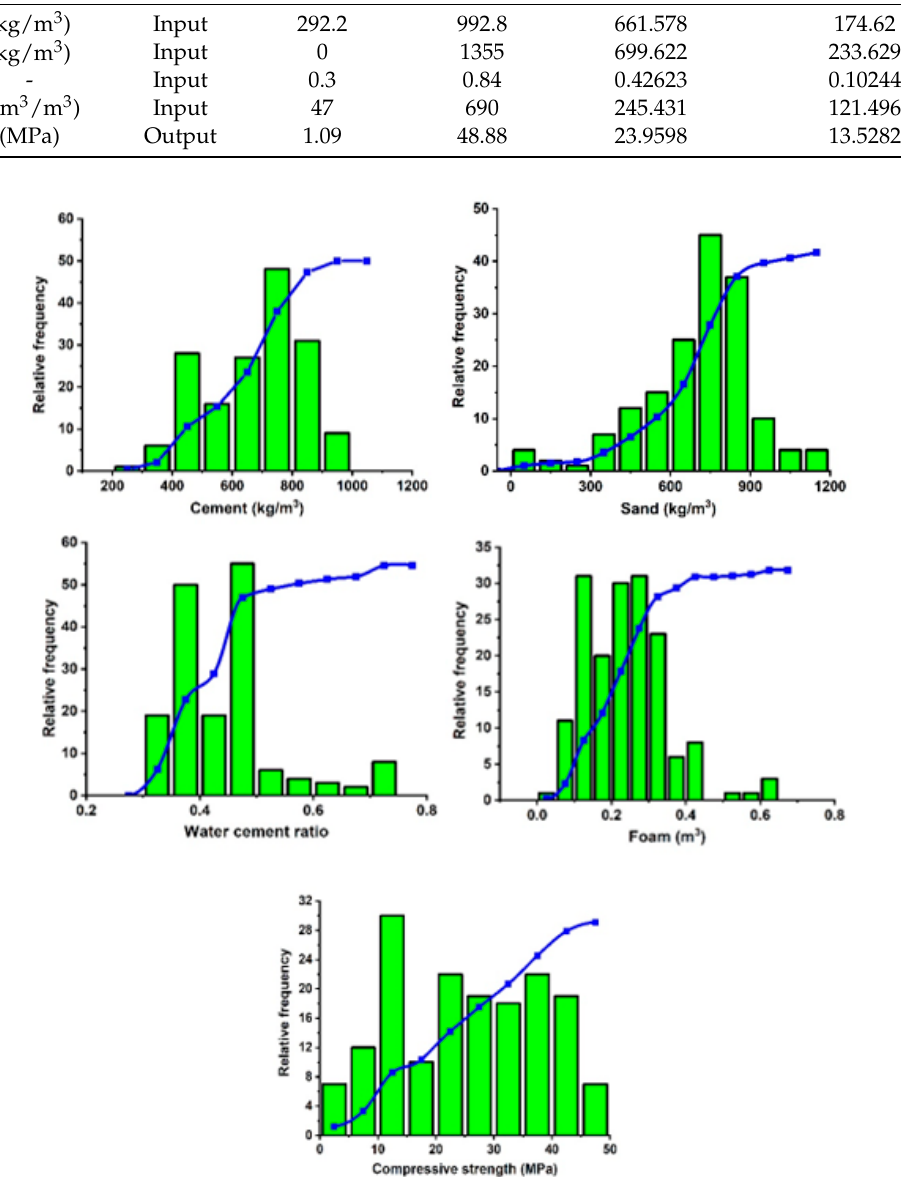
Figure 1. Distribution histogram of collected data .